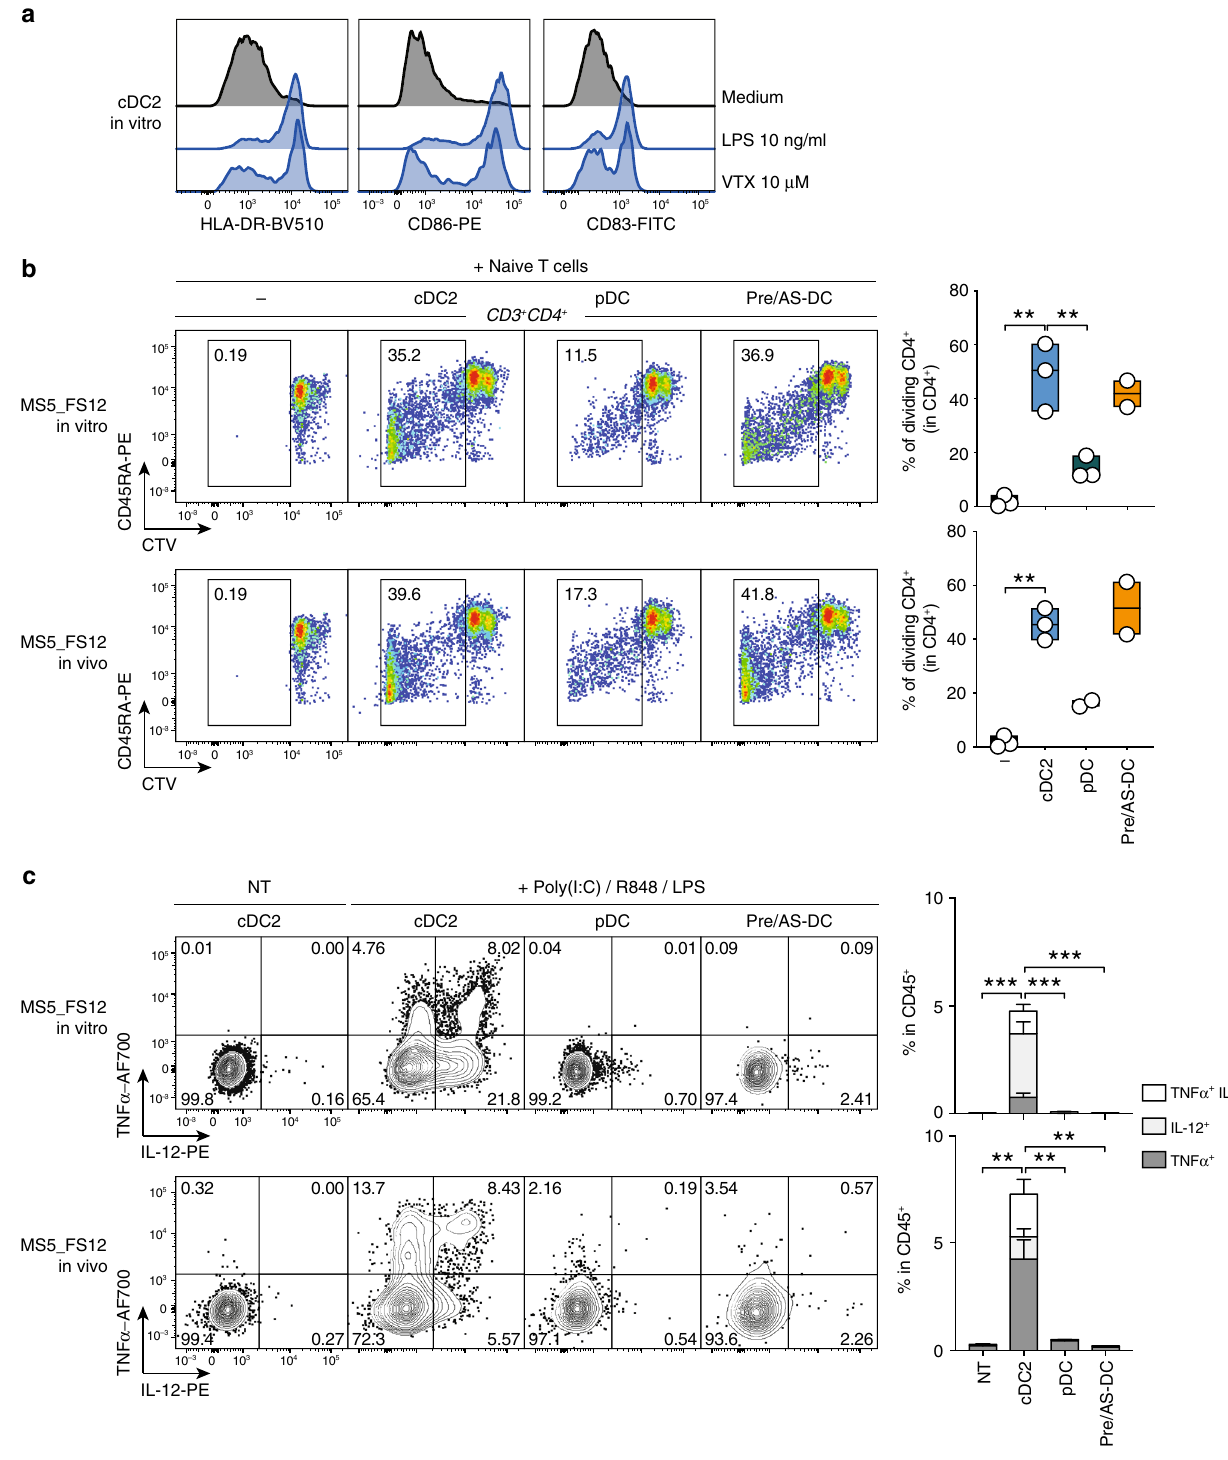
Supplementary Fig. 2a. Cells expressing human membrane-bound FLT3L and SCF manufacturers ’ instructions. Antibodies used in all experiments are listed in Sup- were sorted according to antibody staining of the transmembrane proteins (anti- plementary Table 3. Flow cytometry analysis was performed on LSR Fortessa II bodies listed in Supplementary Table 3). TPO-expressing cells were sorted (BD Biosciences, BD FACSDiva Software) and data were analyzed using FlowJo according to the expression of mCherry reporter. software (TreeStar, version 10.2). Cell sorting was performed using AriaII (BD Biosciences, BD FACSDiva Software). Flow cytometry and fl uorescent-activated cell sorting . Extracellular staining of cells was preformed in FACS buffer, consisting in phosphate-buffered saline (PBS) (Life Technologies), 1% bovine serum albumin (BSA) (Apollo Scienti fi c) and 2 mM EDTA (Life Technologies). For intracellular staining, samples were fi xed and permeabilized using the Cyto fi x/Cytoperm TM kit (BD Biosciences) according to NATURE COMMUNICATIONS| (2020) 11:2054